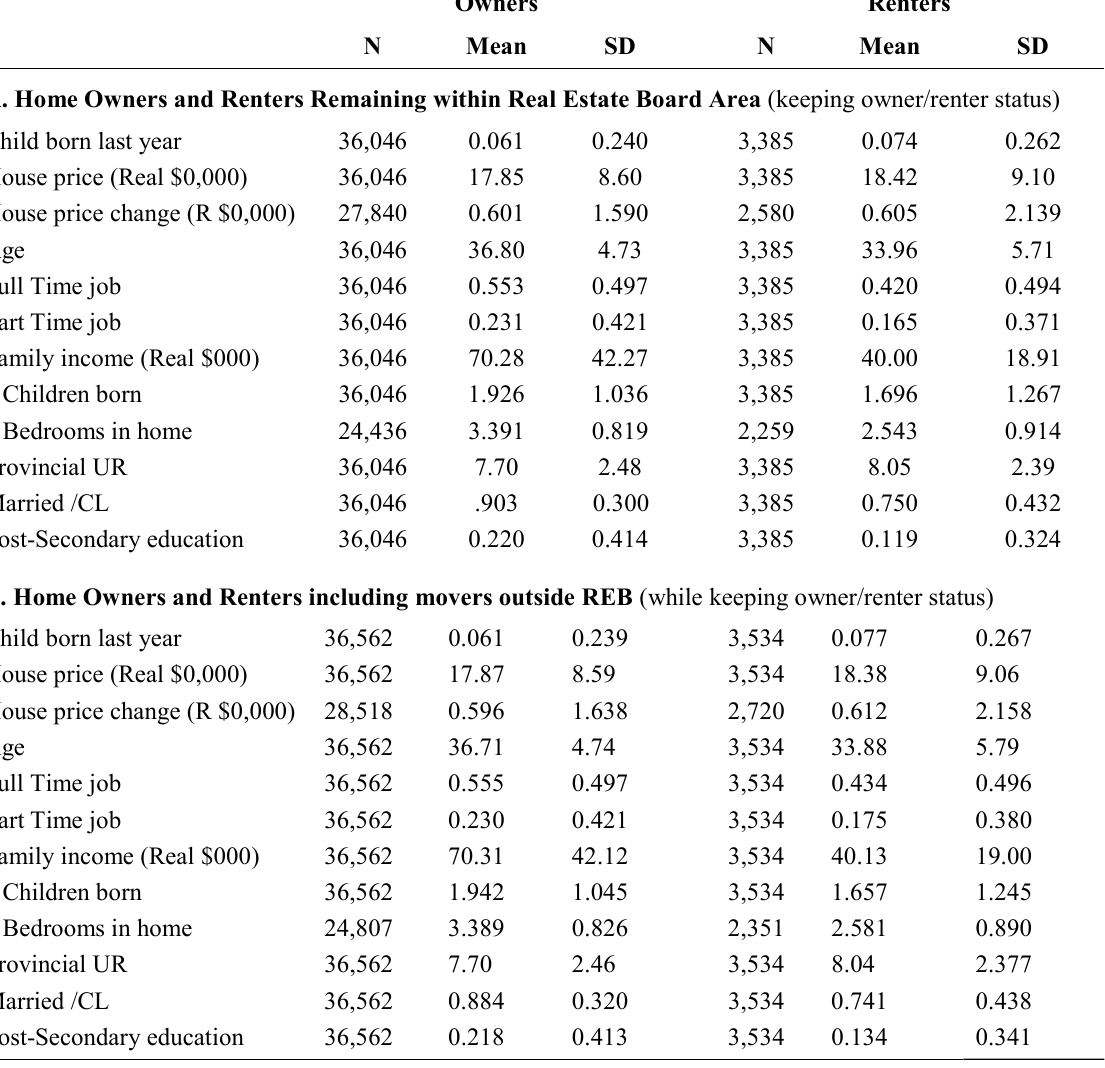
Table 1: Summary statistics (by home ownership and moving status) Owners